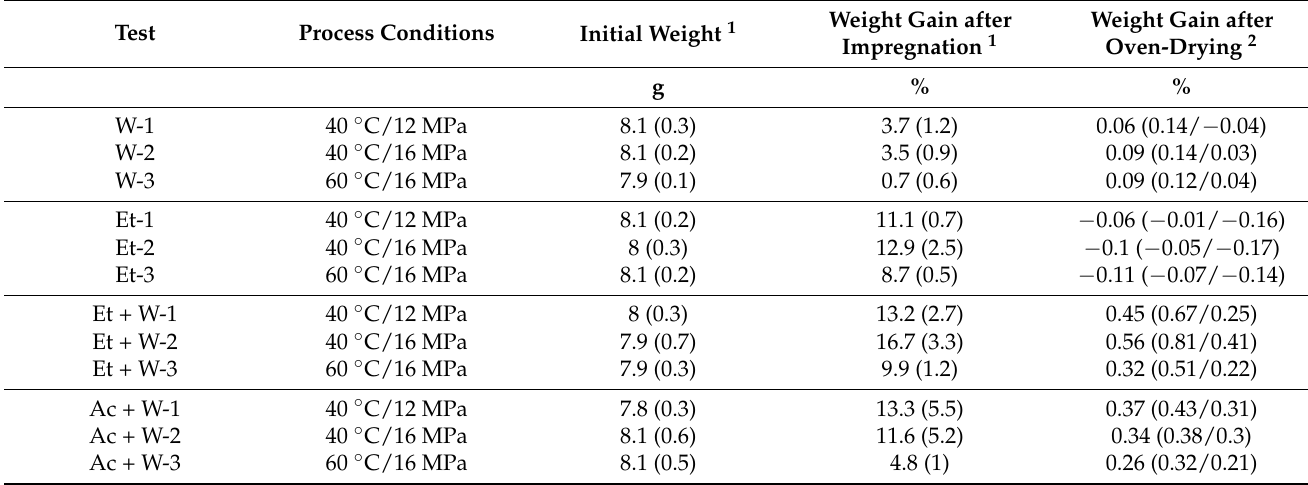
Table 6. Summary of average weight gain measured in triplicate for each treatment.